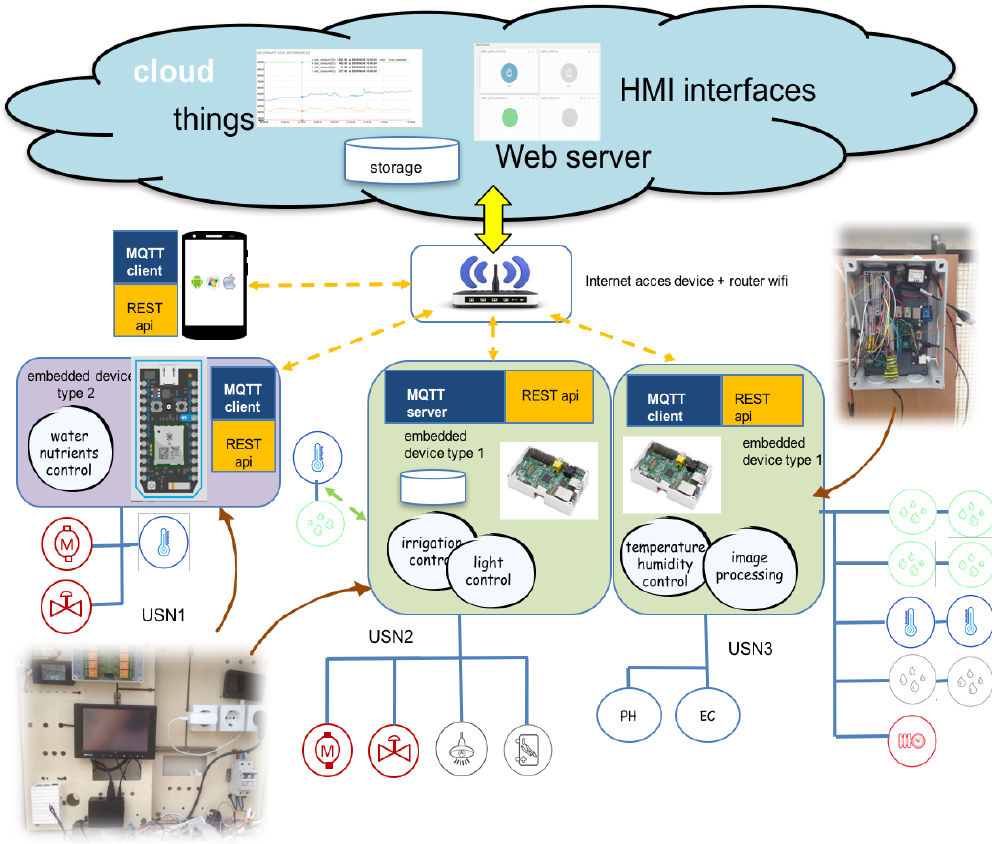
Figure 8. Experimental Hydroponic Station deployment. IoT communication is tested using three USN controlled by two kind of embedded devices. Sensors and actuators are logical variables in Ubidots IoT framework. GUI interfaces, analytic, storage and events programming are tested during plants growth. Control local processes are implemented in these devices.